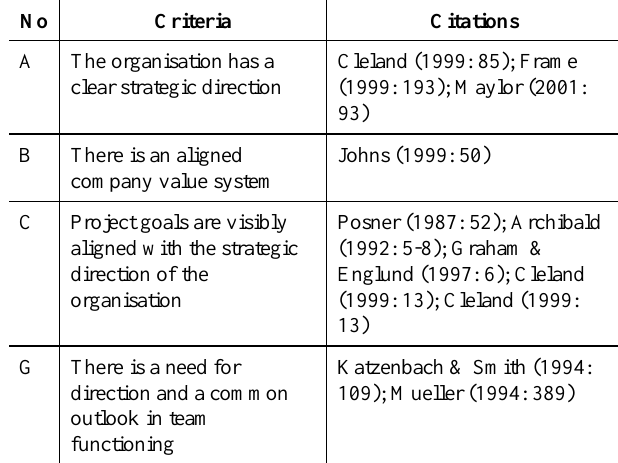
Table 8: The need for an external focus